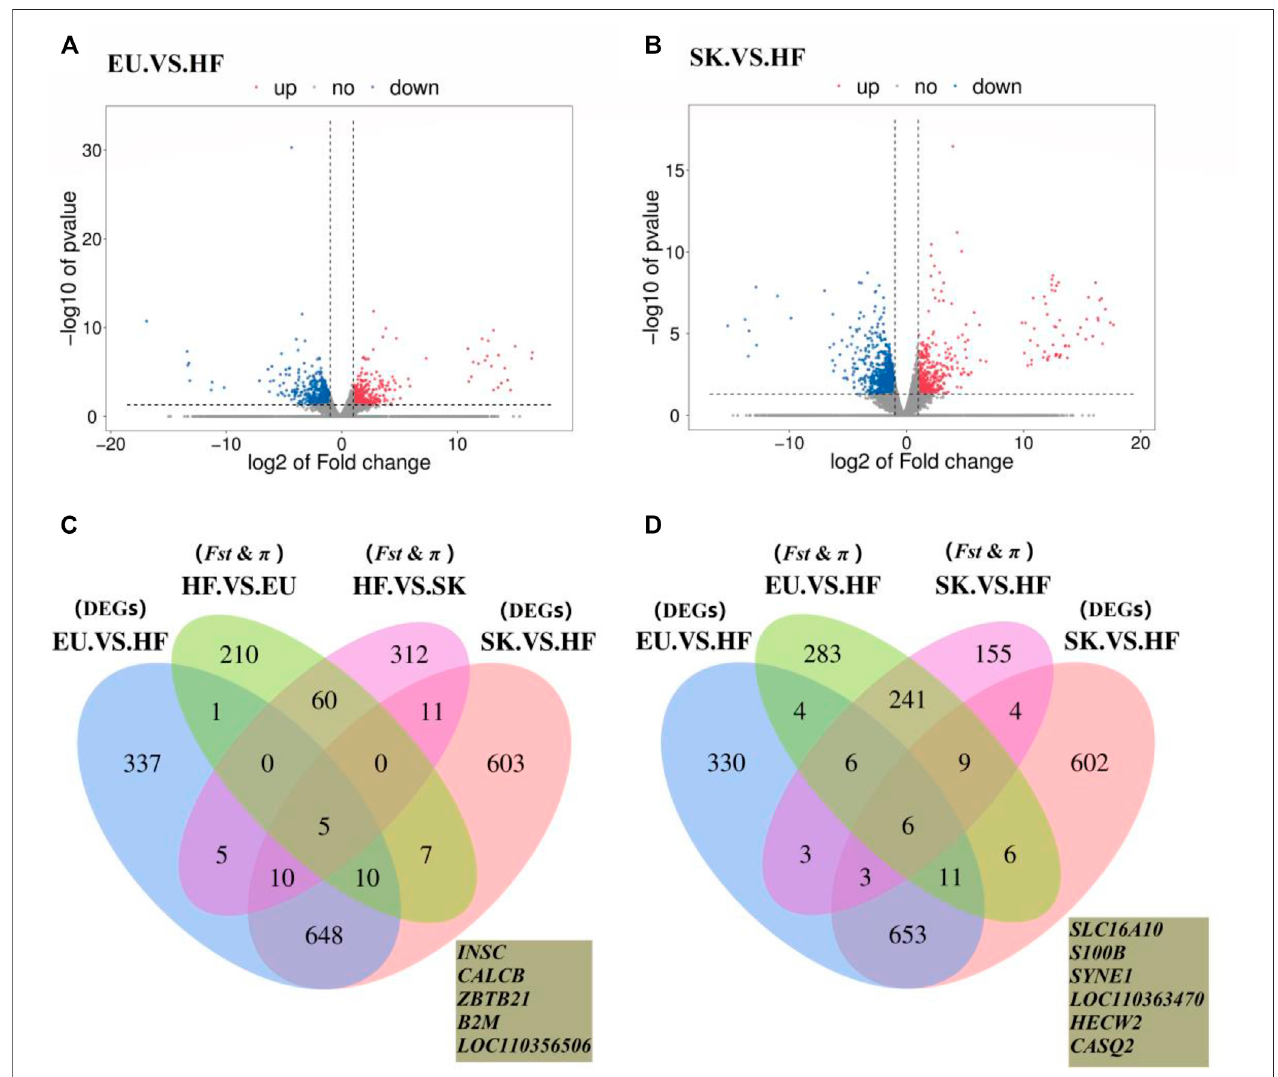
FIGURE 3 | (A) Volcano plot of EU. VS. HF breast muscle differential gene expression level. (B) Volcano plot of SK. VS. HF breast muscle differential gene expression level. (C) Venn diagram of the commercial pigeon positive selection signal combined with DEGs analysis of the breast muscle transcriptome. (D) Venn diagram of the HF positive selection signal combined with DEGs analysis of the breast muscle